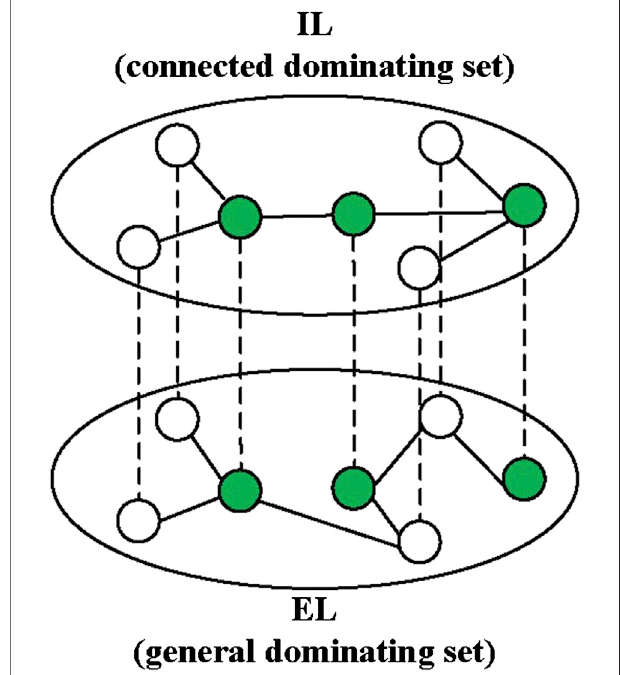
FIGURE 1 | The set of green nodes is a special MDS of the duplex network. It is a general dominating set of the EL and a connected dominating set of the